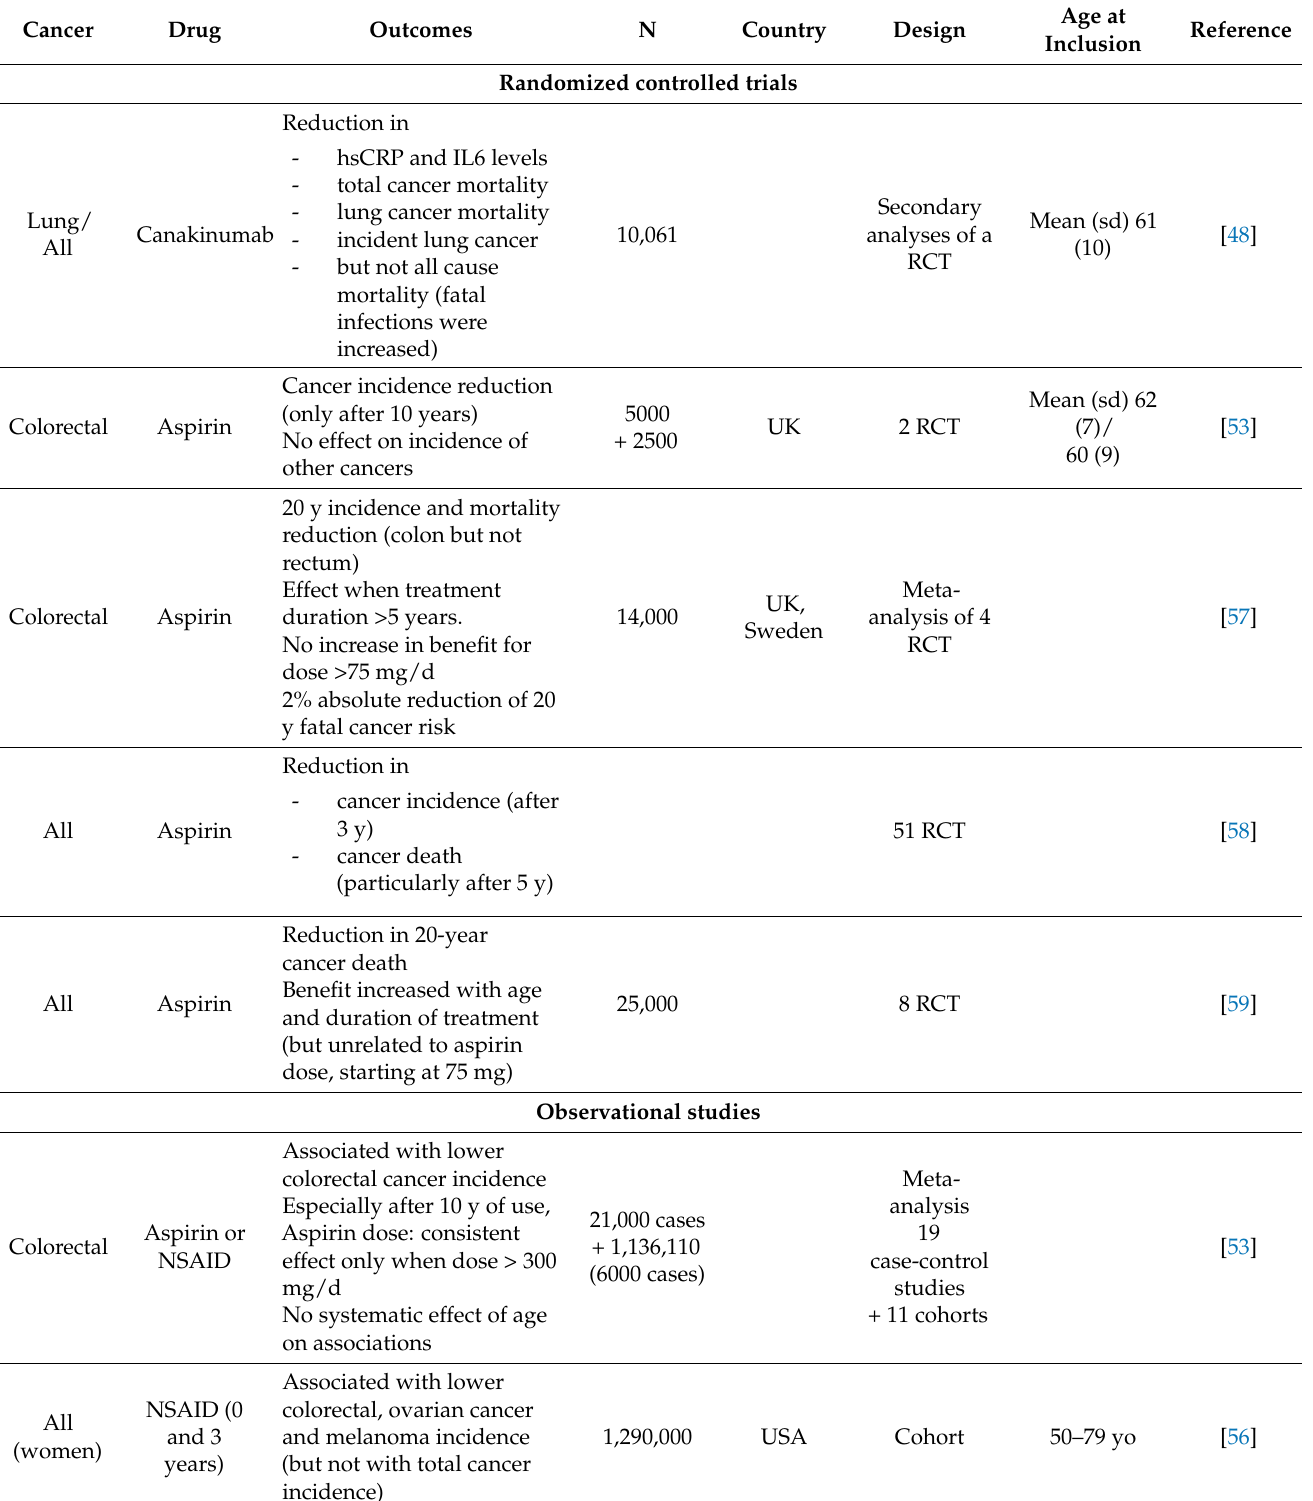
Table 2. Studies of effect of anti-inflammatory drugs on cancer incidence and mortality.